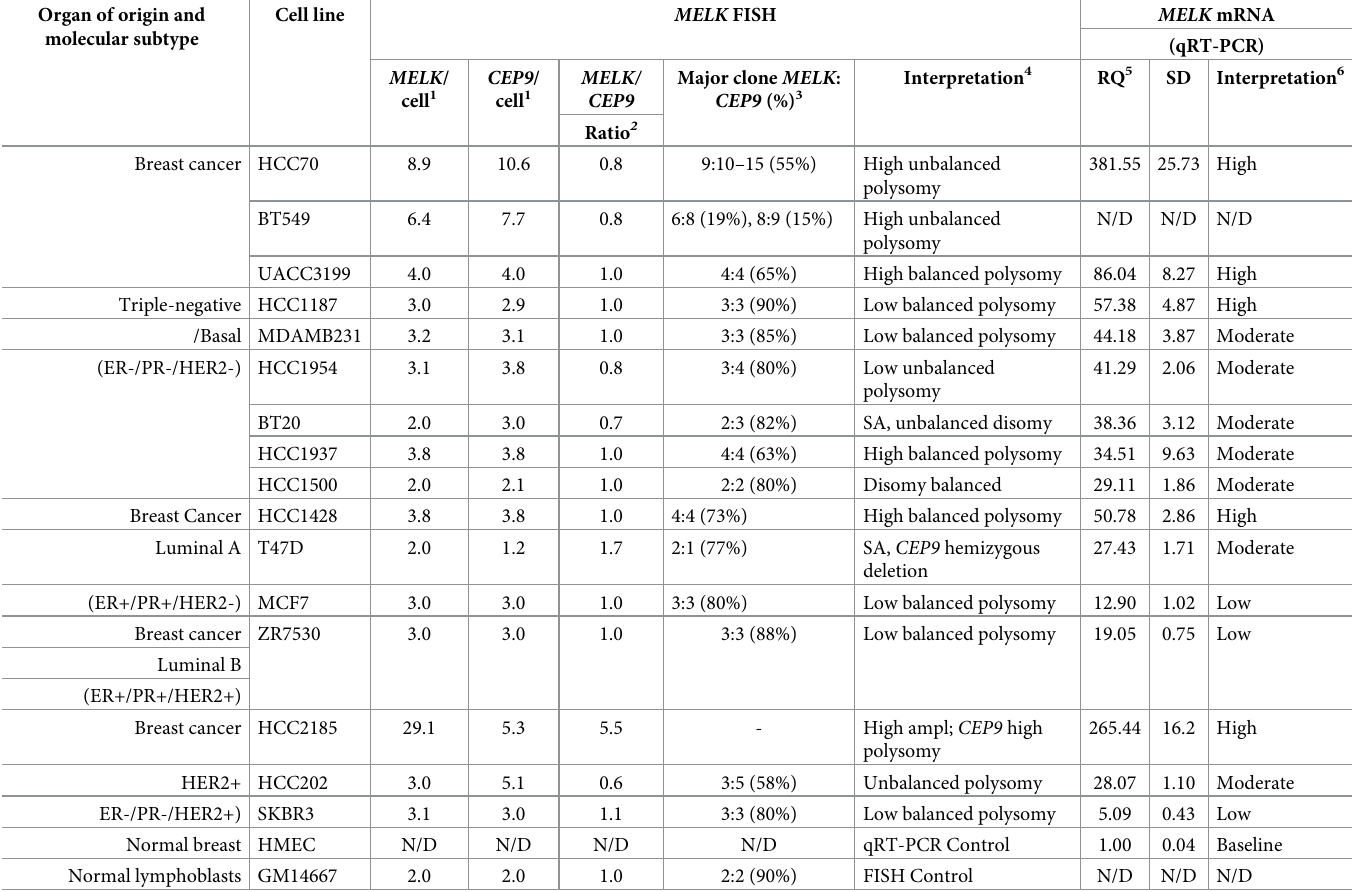
Table 1. MELK gene copies and RNA expression in breast cancer cell lines. Organ of origin and Cell molecular subtype